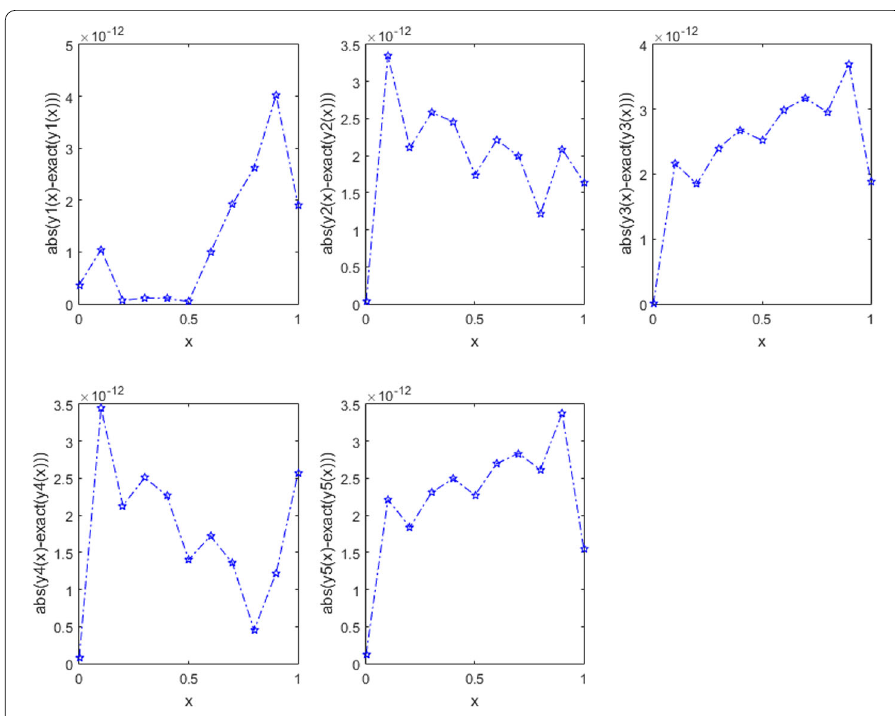
Figure 11 The absolute error of Example 14